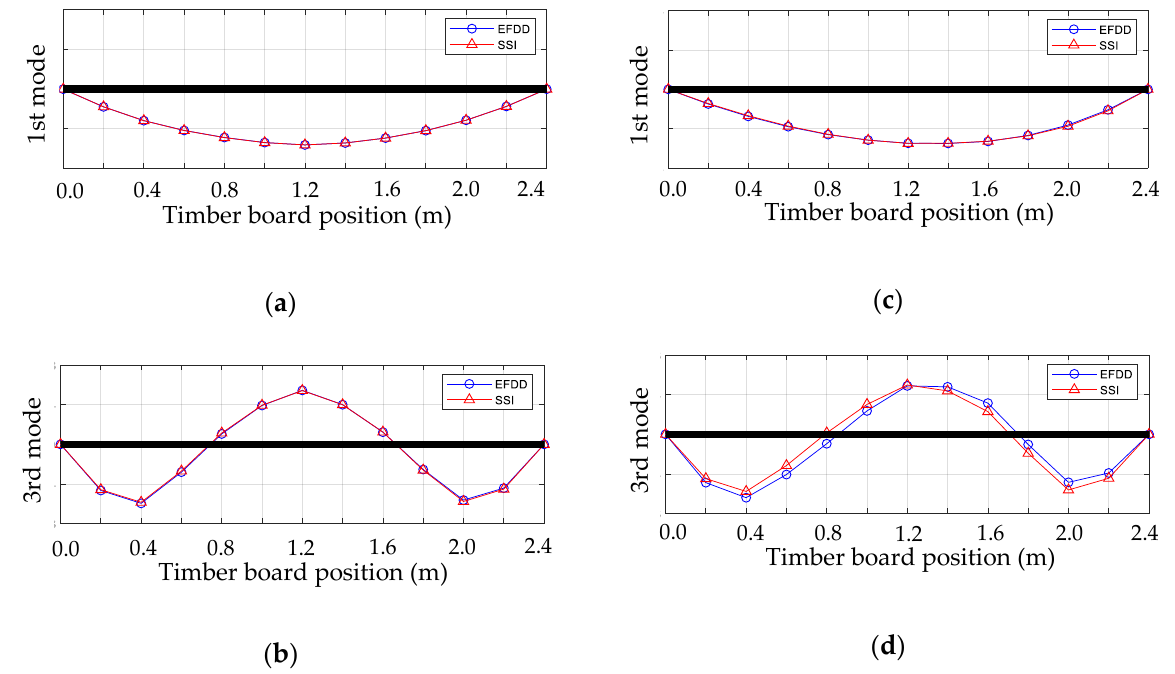
Figure 11. Graphical comparison between the experimental modal shapes obtained by EFDD and SSI methods in: ( a ) Timber board #20—first mode; ( b ) timber board #20—third mode; ( c ) timber board #28—first mode; ( d ) timber board #28— third mode.